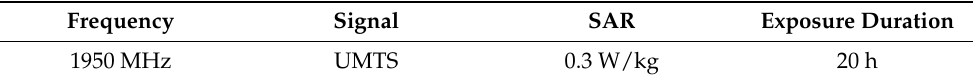
Table 1. Exposure conditions employed in the experiments. Frequency Signal SAR Exposure Duration 1950 MHz UMTS 0.3 W/kg 20